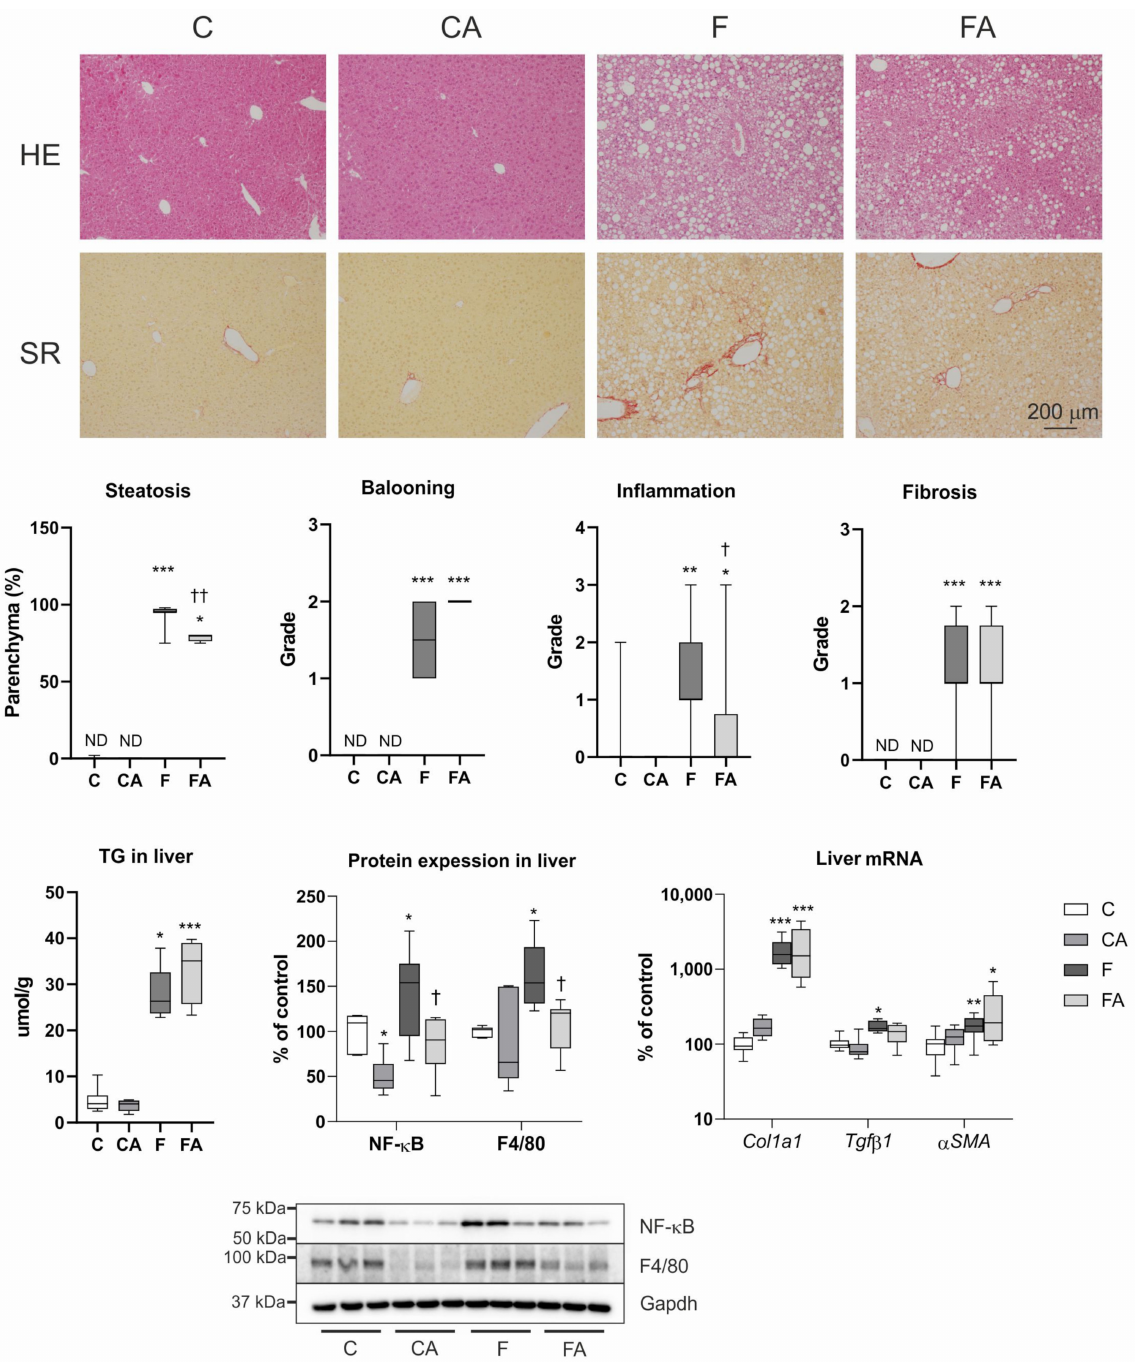
Figure 2. Atorvastatin treatment reduced steatosis and inflammation in mice with NASH. Representative hematoxylin and eosin (HE) and Sirius red (SR) staining (magnification × 100). NASH was induced in mice by 24 weeks of F diet consumption, with atorvastatin (A) administered orally (20 mg/kg/day) during the last three weeks. Corresponding